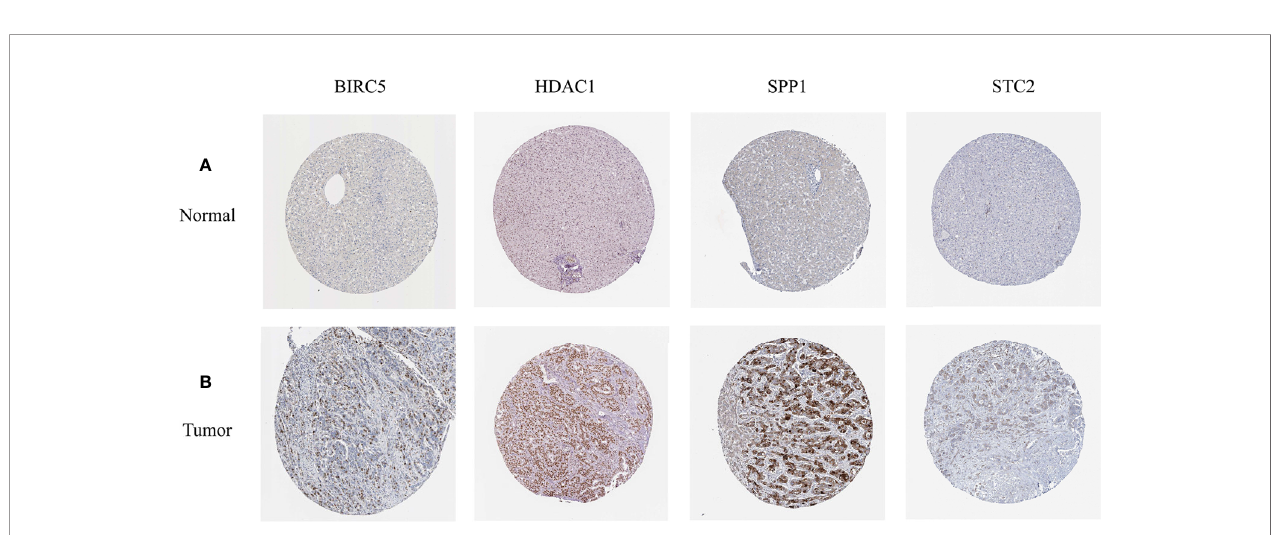
FIGURE 10 | (A, B) The expression pro fi les of these fi ve genes in normal liver tissues and hepatocellular carcinoma tissues. The results of immunohistochemistry were all from HPA database.